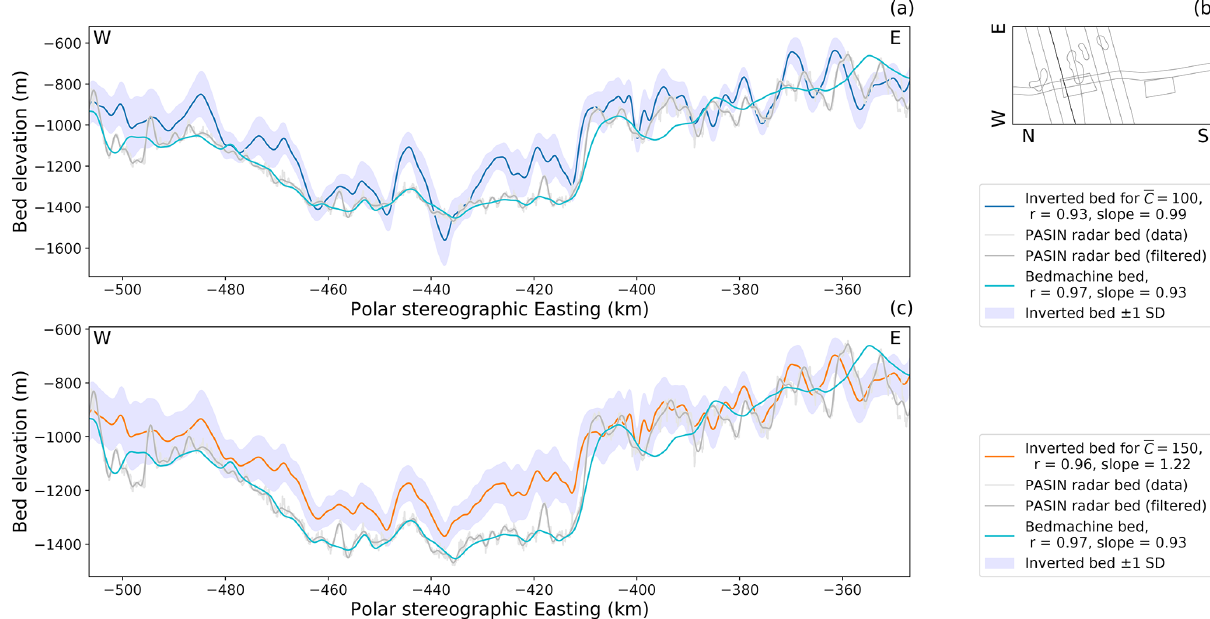
Figure 8. (a) Comparative plot of inverted bed topography with mean non-dimensional slipperiness C = 100 with across-flow radar-sounded bed topography. Key as for Fig.